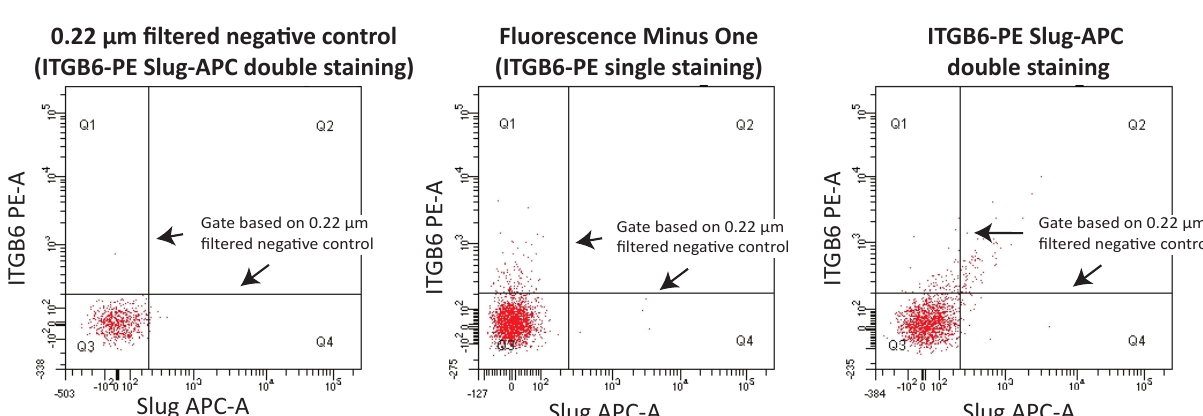
Figure 2. Unstained control, fluorescence minus one control, 0.22 µ m filtered negative control. ( A ) Gating strategy of single ITGB6-PE(+)MPs in NLFs, ( B ) gating strategy of double slug-APC(+) ITGB6-PE(+) MPs in NLFs. Background noise is obviously included when the fluorescence-positive gate of ITGB6(+)MP subtypes were set according to unstained control or fluorescence minus one control. Thus, we used the 0.22 µ m filtered negative samples to exclude background noise and set the fluorescence-positive gate of ITGB6(+)MP subtypes. Before the stained NLF samples were analyzed by flow cytometry, they were filtered using 0.22 µ m membrane filters to exclude MPs in them. The filtered samples were used as negative MP controls when MPs were analyzed using the conventional flow cytometry, whose detection limit of particles was more than 0.3 µ m. Adapted with permission from John Willey and Sons. Ltd., Allergy, Takahashi T, et al., 75, 3261–3289, copyright 5177010584585